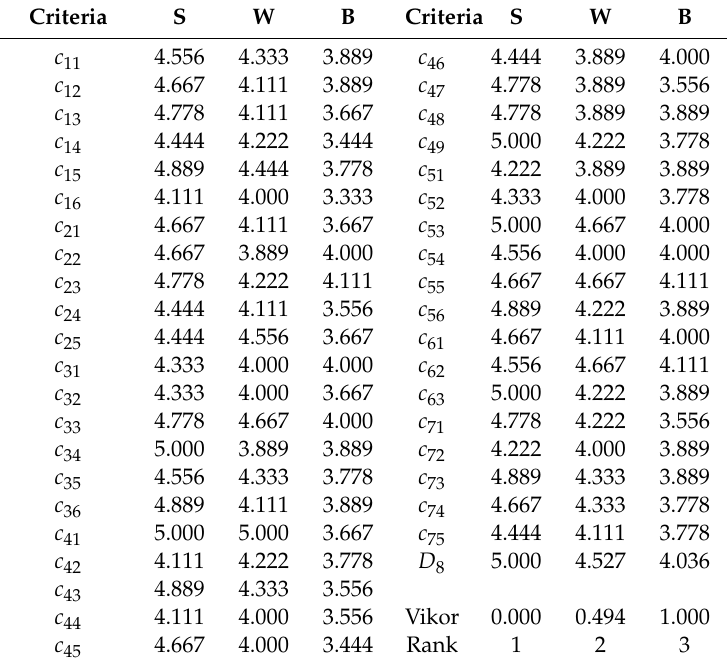
Table 7. Performance Scores of the Three Investment